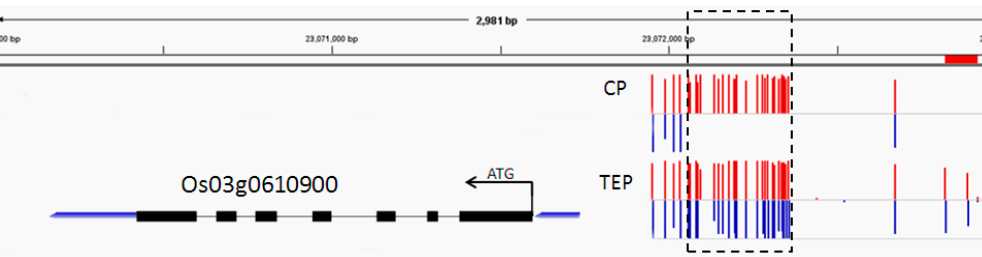
Figure 10. Comparison of the methylation degree of the promoter region of the Os03g0610900 gene before and after cold stress. Red color indicates increased methylation levels, and blue indicates decreased methylation levels. CP: control group that did not undergo cryotherapy; TEP: experimental group that underwent cold treatment.